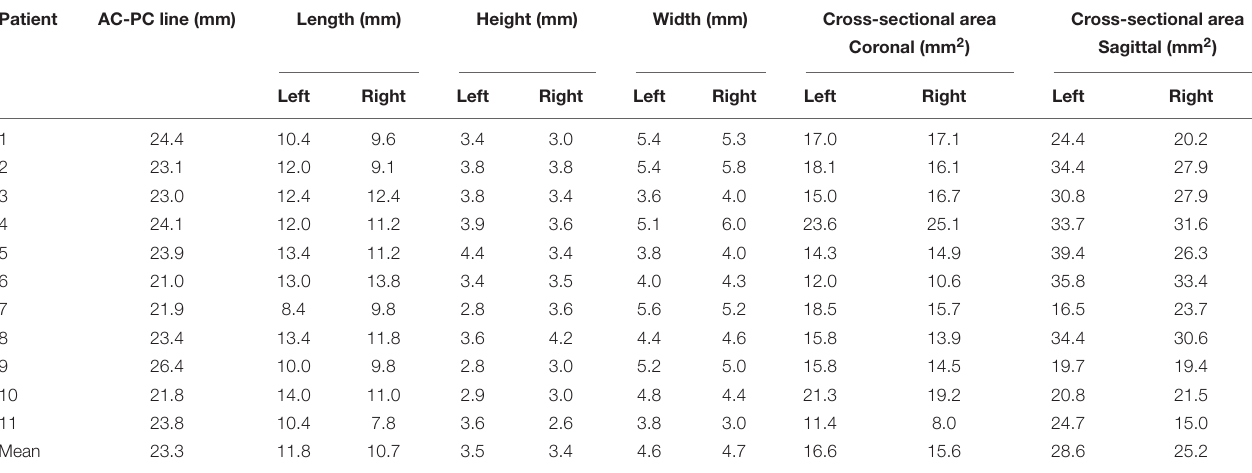
TABLE 2 | Morphological features of the ANT in study patients.